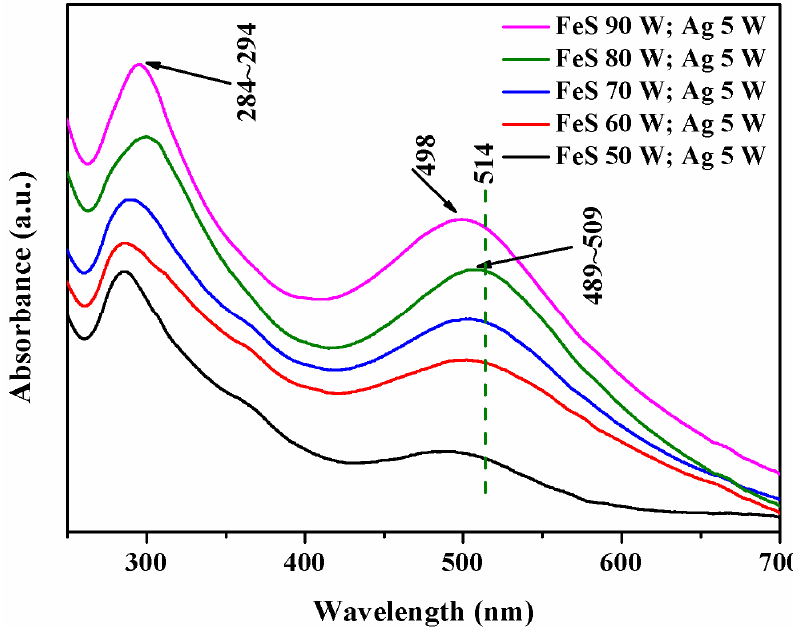
Figure 2. UV-Vis absorbance spectra of cosputtered Ag and FeS; Ag was deposited with a constant sputtering power (5 W) and FeS was deposited with varied sputtering powers (50 W, 60 W, 70 W, 80 W and 90 W) for 300 s on PSCP templates.